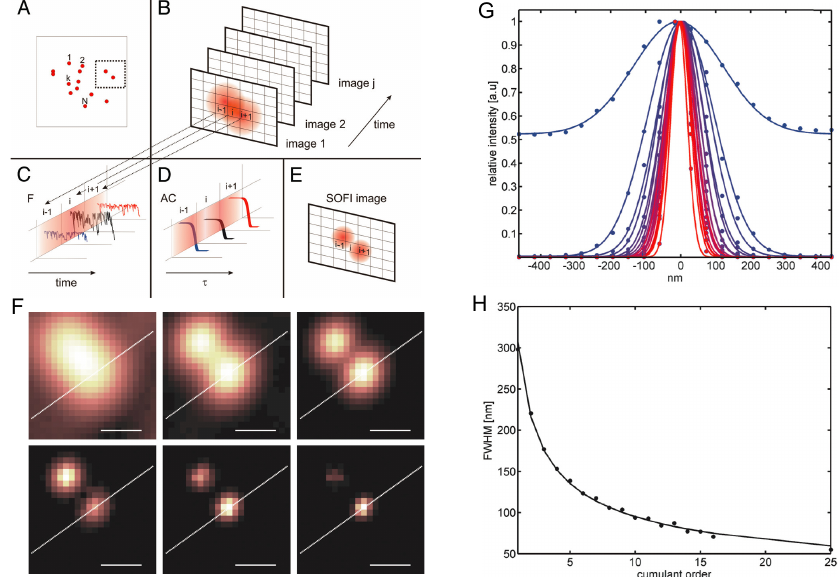
Figure 3. Super-resolution fluorescence imaging through optical fluctuation. The object to be imaged consists of many independent fluorescent emitters ( A ); and the fluorescent intensity of the image spot fluctuates independently for different emitters ( B , C ). By taking advantage of the bunching effect of the optical fluctuation ( D ); super-resolution image can be realized ( E ). Super-resolution images demonstrated in experiment ( F ) clearly show that the imaging resolution increases with cumulant orders, confirmed by the one-dimensional Gaussian fit of the cross-sections ( G ). The reduced full width at half maximum (FWHM) of the fitted Gaussian curves upon the cumulant orders is plotted in ( H ). Scale bars in ( F ): 250 nm. The figure is reproduced with permissions from Ref. [33] of PNAS.